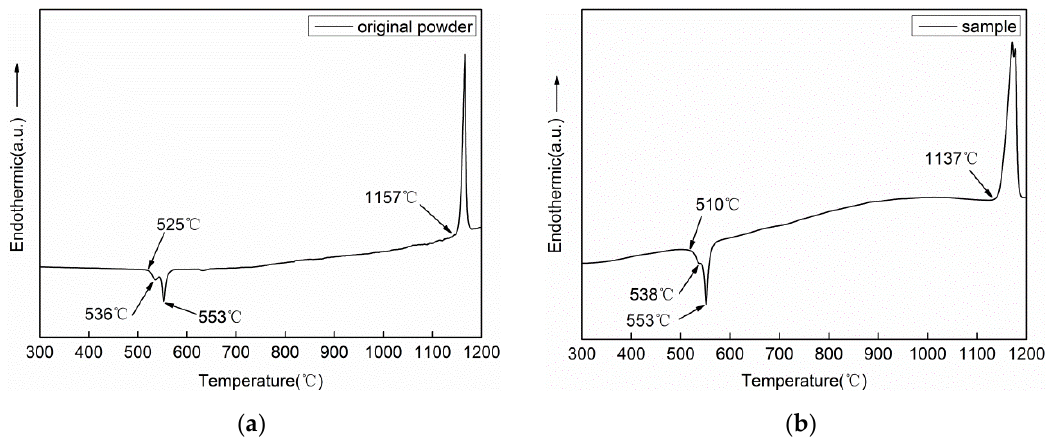
Figure 5. Differential scanning calorimetry (DSC) curves of the original powder ( a ) and the sample ( b ).